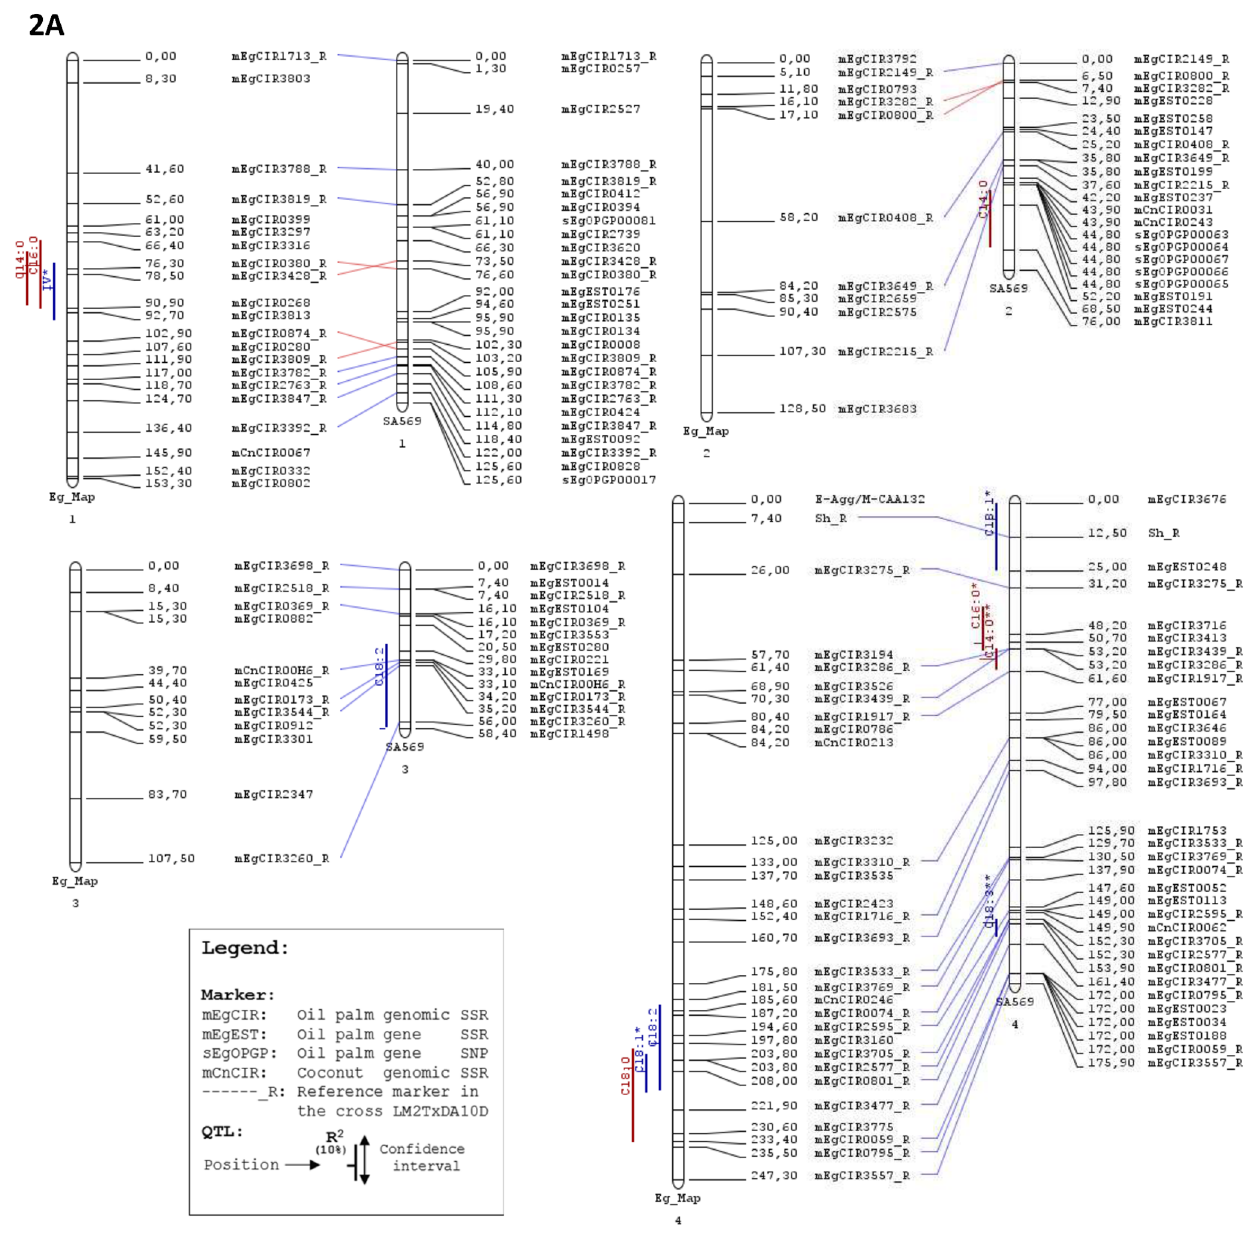
Figure 2. Sixteen QTLs of palm oil fatty acid proportions and iodine value identified in the E.guineensis cross LM2T x DA10D, located on the consensus linkage map in oil palm (Eg_Map) of Billotte etal. [36] and compared to the QTL map for same traits published by Montoya etal. [27] in the interspecific Elaeis pseudo-backcross SA569. Note: Each microsatellite linkage map has 16 linkage groups corresponding to the 16 homologous pairs of chromosomes of the Elaeis genome. The E. guineensis Eg_Map (253 loci) is sharing 156 marker loci in common and good co-linearity with the linkage map of the pseudo-backcross SA569 (362 loci). The QTLs were identified by the Kruskal-Wallis, IM and MQM methods. One star (*) or two stars (**): QTL detected by the MQM method at the genome-wide a threshold value of 5% or 1% respectively. No star: putative QTL as only detected by the Kruskall-Wallis test at p , 0.005. The names and the positions (cM) of the markers are given on the right side of the linkage groups. mEgCIRxxxx and mEgESTxxxx: E. guineensis SSR loci. sEgOPGPxxxx: E. guineensis gene SNP loci. mCnCIRxxxx: Cocos nucifera SSR loci. Marker loci common to both maps are indicated by an extension ‘‘_R’’. The names, positions and confidence regions of the QTLs are given on the left side of the linkage groups. In red: are figured the QTLs of saturated fatty acid proportion; in blue: the QTLs of unsaturated fatty acid proportion and of iodine value. doi:10.1371/journal.pone.0095412.g002 linoleic acid (C18:2), for which E. guineensis seemed to be dominant except for C18:2, which showed a non-additive genetic determin- ism, with LM2T appearing dominant over DA10D, consistent for its corresponding allelic genetic factors. Our study clearly with Hardon [7]. confirmed the additive genetic determinants of fatty acid proportions in our E. guineensis cross, as the mean values of Similarly, our results on the interspecific pseudo-backcross are LM2T x DA10D progeny were the mean values of their parents, consistent with Tan et al. [23], who reported a co-dominant